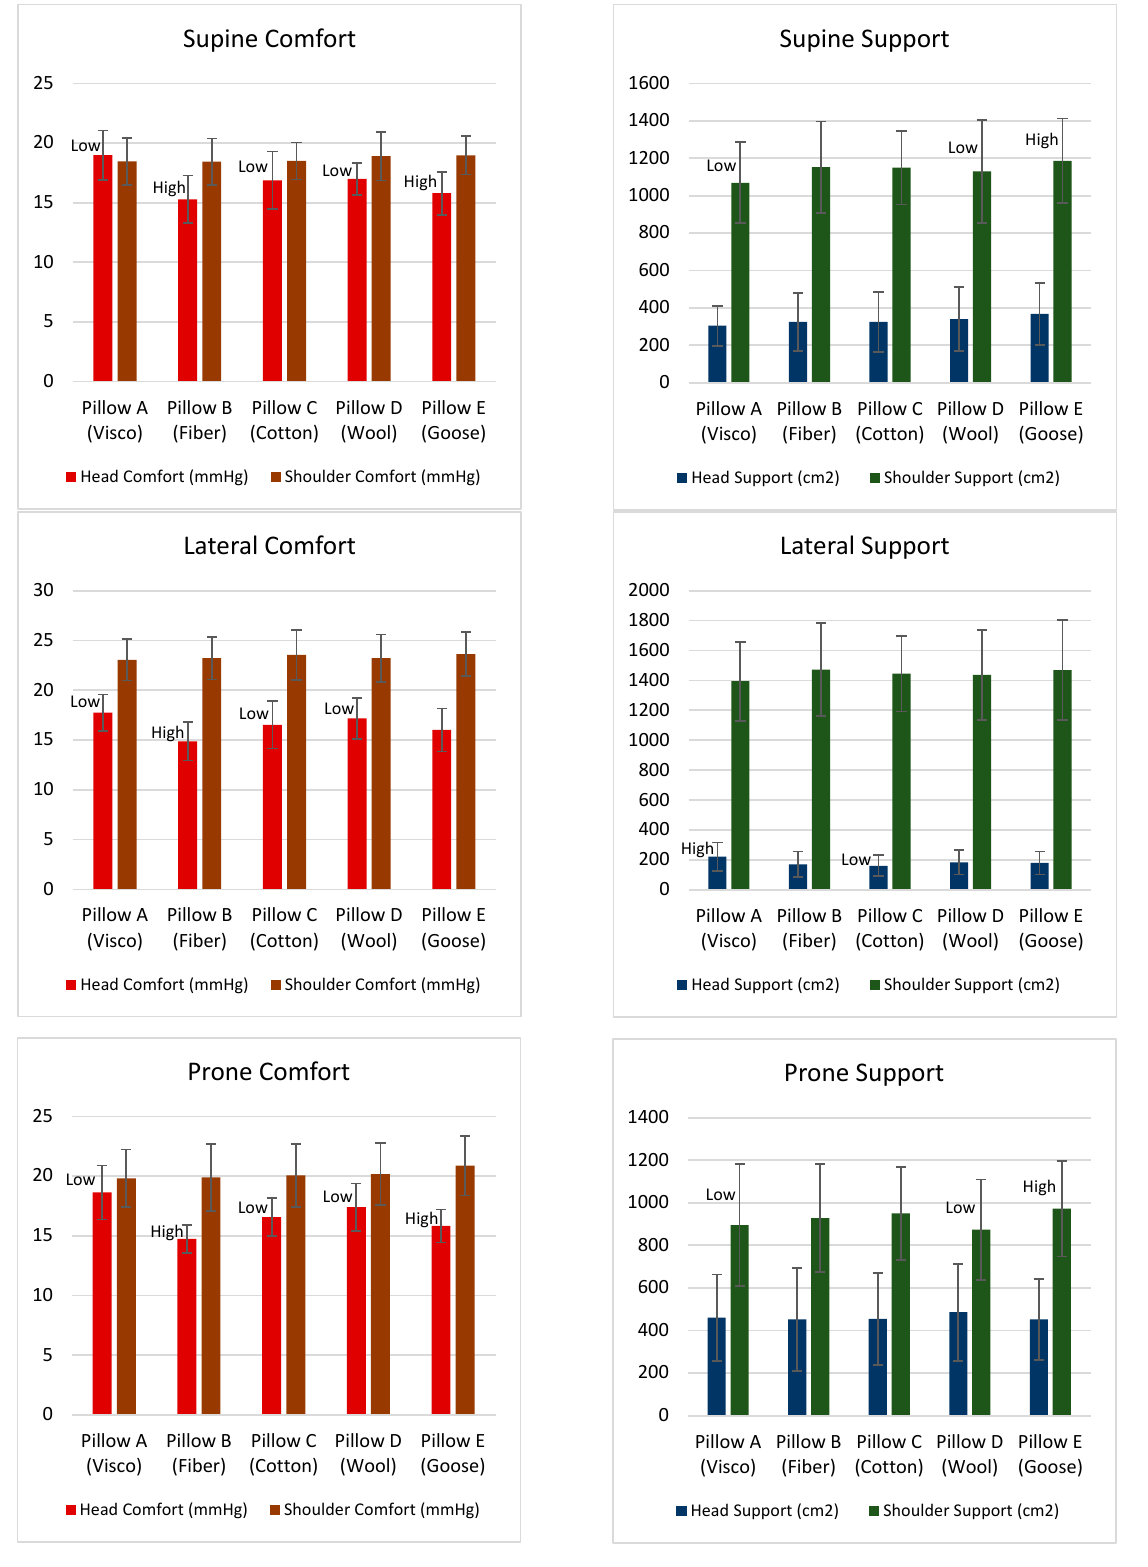
Figure 4. Graphical representation of the comfort and support values provided to individuals with FHP by different pillow designs.